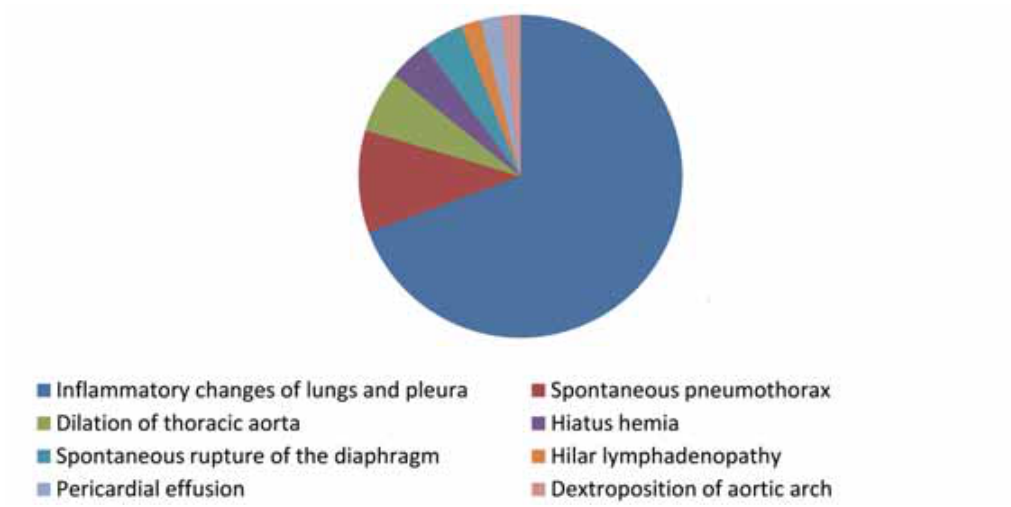
FIGURE 2. Number of diagnosis (n=49), MSCT results with potentially benign